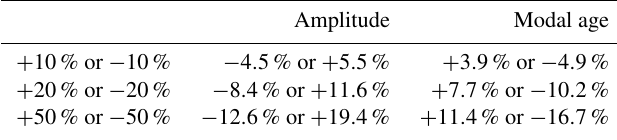
Table 3. Percentage deviations of spectra amplitudes and modal ages averaged over all three subsets presented in Fig. 12. The calcu- lated values are relative to the spectra of each subset without errors in the knowledge of chemical lifetime. Amplitude Modal